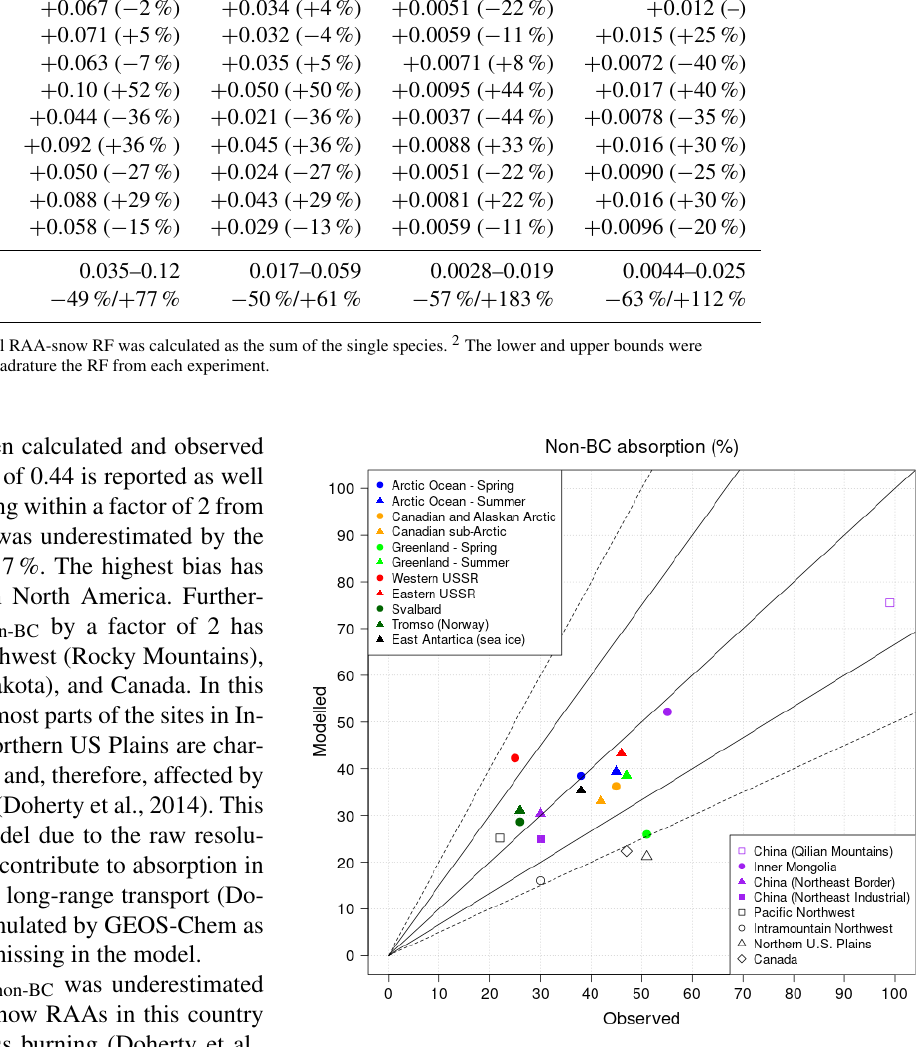
Figure 3. Scatterplots of the observed and modeled f non-BC in the snow. The central continue line is the 1:1 line; other continue lines correspond to 1:1.5 and 1.5:1 lines. Dotted lines correspond to 1:2 and 2:1 lines. Non-BC means the sum of BrC and dust (reported as BC